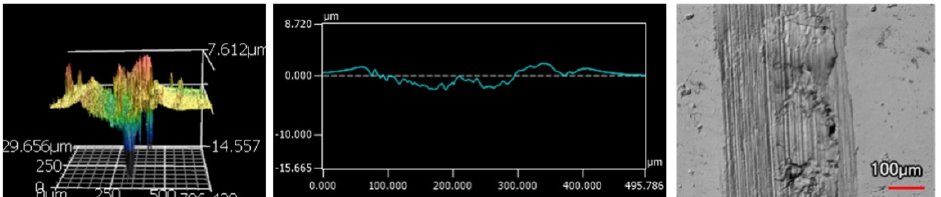
Figure 20. Volume Loss from the Sharp Indenter.